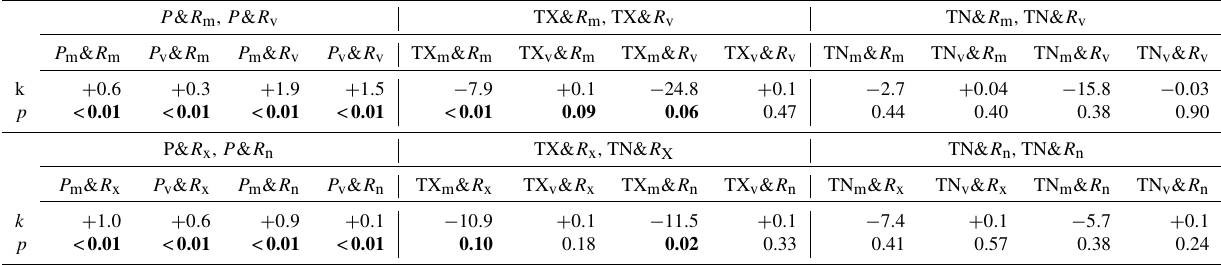
Table 5. Sensitivity of streamflow to changes in means and variances of precipitation and